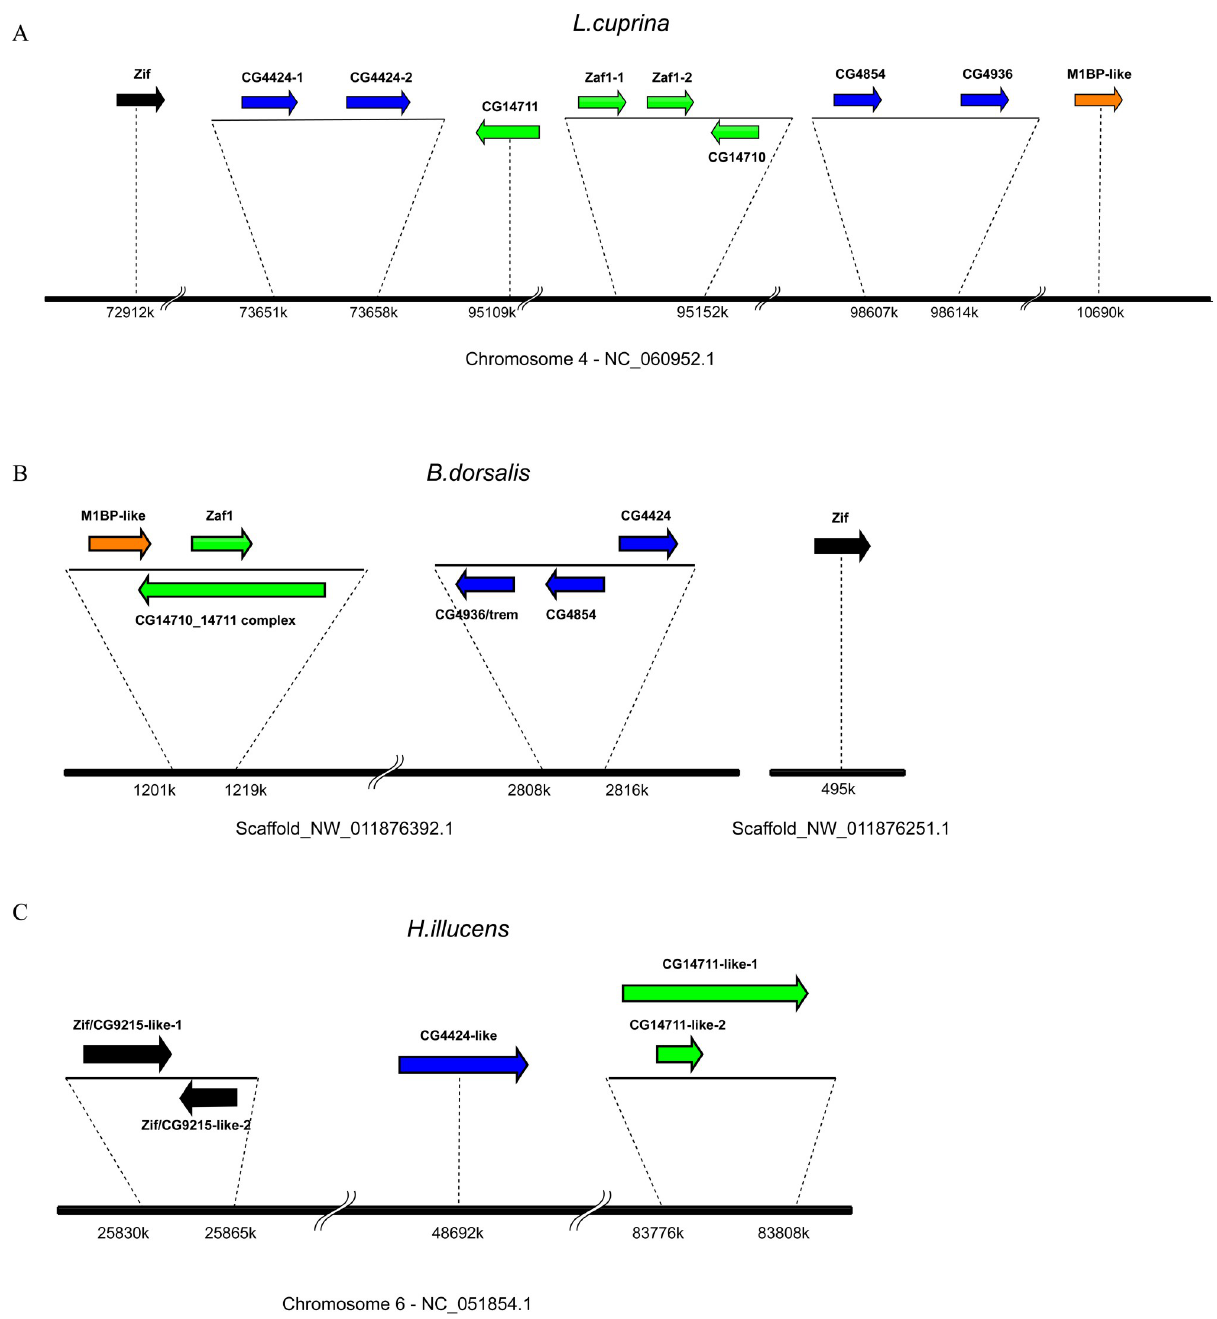
Fig 6. Syntenies of cucoid orthologs in Lucilia, Bactrocera, and Hermetia. Genes are color coded to indicate their relationship to gene clusters in D . melanogaster . (A) Synteny of cucoid orthologs in Lucilia cuprina . (B) Synteny of cucoid orthologs in Bactrocera dorsalis . (C) Synteny of cucoid orthologs in Hermetia illucens